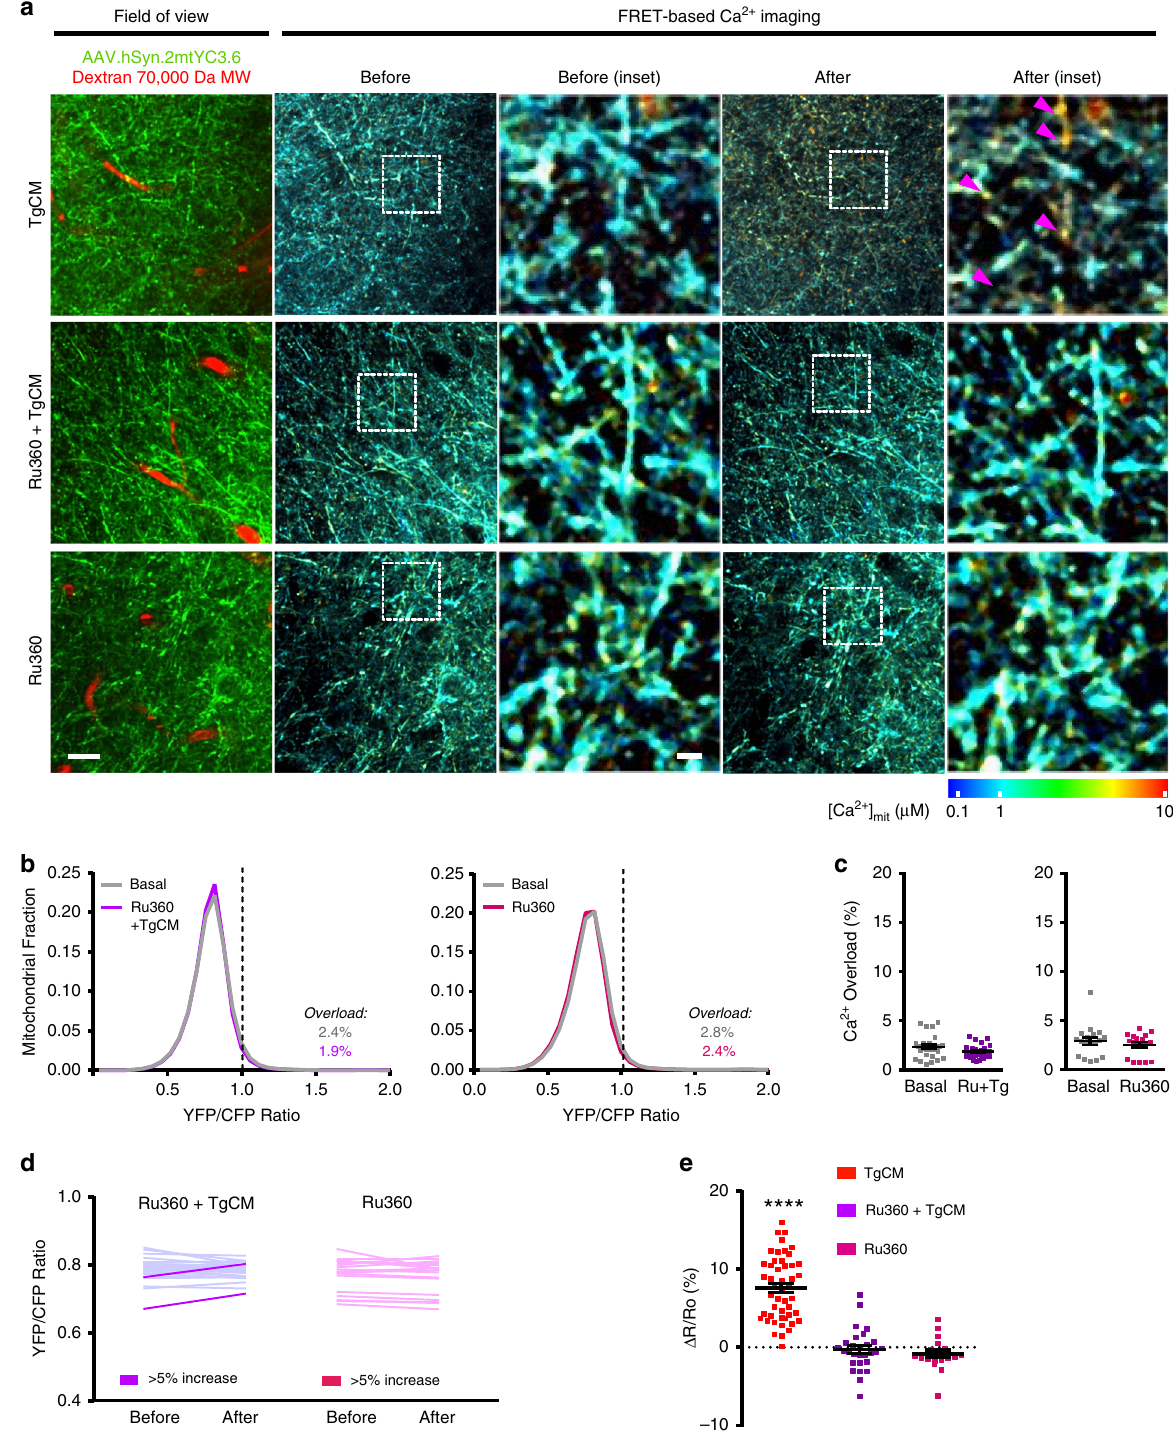
Fig. 5 MCU is required for the A β -induced mitochondrial Ca 2 + increase in vivo. a Representative pictures of the effects of the MCU complex blocker Ru360 on the increase of [Ca 2 + ] mit induced by TgCM. Arrow heads show mitochondria with high [Ca 2 + ]. Scale bar 20 and 5 µ m for the inset. b Graphs show histogram of [Ca 2 + ] mit frequency distribution (expressed as YFP/CFP ratio) before and after topical application of TgCM in presence of Ru360 and of Ru360 alone. The percentage of Ca 2 + overload before (basal) and after TgCM application in presence of Ru360 is noted. c Scatter dot plot represents the percentage of mitochondria showing Ca 2 + overload before and after application of CM for every volume acquired. Error bars represent mean ± SEM (Ru360 + TgCM: before 2.37 ± 0.47% vs. after 1.89 ± 0.27%, non-signi fi cant, n = 28 z -stacks from 4 mice. Ru360: before 2.82 ± 0.86% vs. after 2.41 ± 0.78%, non-signi fi cant, n = 18 z -stacks from 3 mice). d Averaged YFP/CFP ratios before and after treatment for each z -stack acquired. The dark traces account for the z -stacks that showed an increase ≥ 5% in YFP/CFP ratio after topical application of the treatment. e Scatter dot plot represent the relative change in YFP/CFP ratio for each condition. Bars represent mean ± SEM (7.60 ± 0.81%, 48 z -stacks TgCM; − 0.27 ± 1.05%, 28 z -stacks Ru360 + TgCM; − 0.92 ± 1.25%, 18 z -stacks Ru360 from 7, 4 and 3 mice, respectively, **** p <